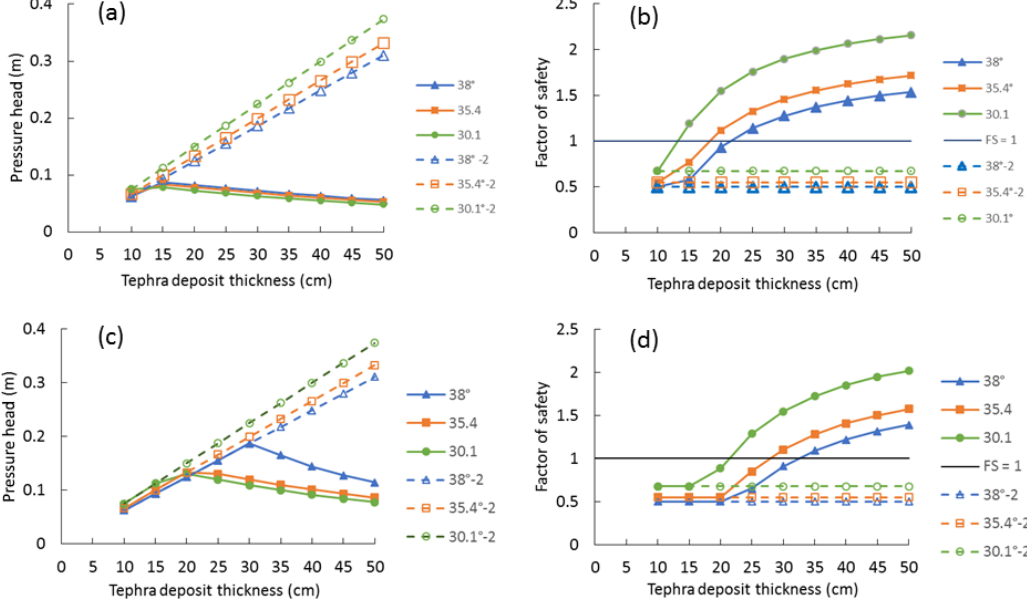
Figure 12. Total pressure head and factor of safety versus tephra fallout deposit thicknesses between 0.1 and 0.55m for subplinian tephra fallout deposits with K s = 1 × 10 − 2 ms − 1 and K s = 6 . 8 × 10 − 4 ms − 1 (dashed lines) for two different rainfall intensities and durations: (a, b) 6.4mmh − 1 with a duration of 5h; (c, d) 15.5mmh − 1 with a duration of 3h (see also Table